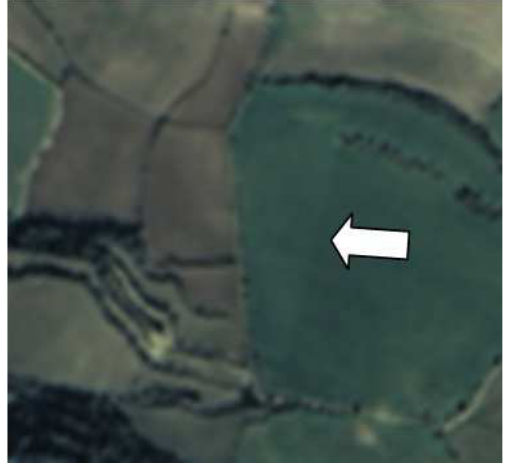
Figure 7 . Radiometric discontinuity